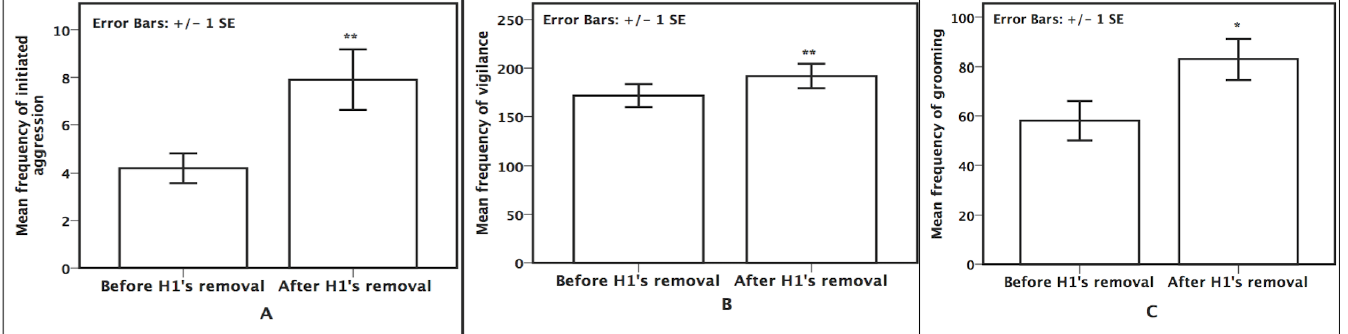
Fig 2. Frequencies of behaviors within matriline 3 before and after H1’s removal. Frequencies represent the average number of intervals (out of 400) the behavior occurred for each focal subject. A. Aggression frequency ** p = 0.01. B. Grooming frequency ** p = 0.01. C. Vigilance frequency * p =